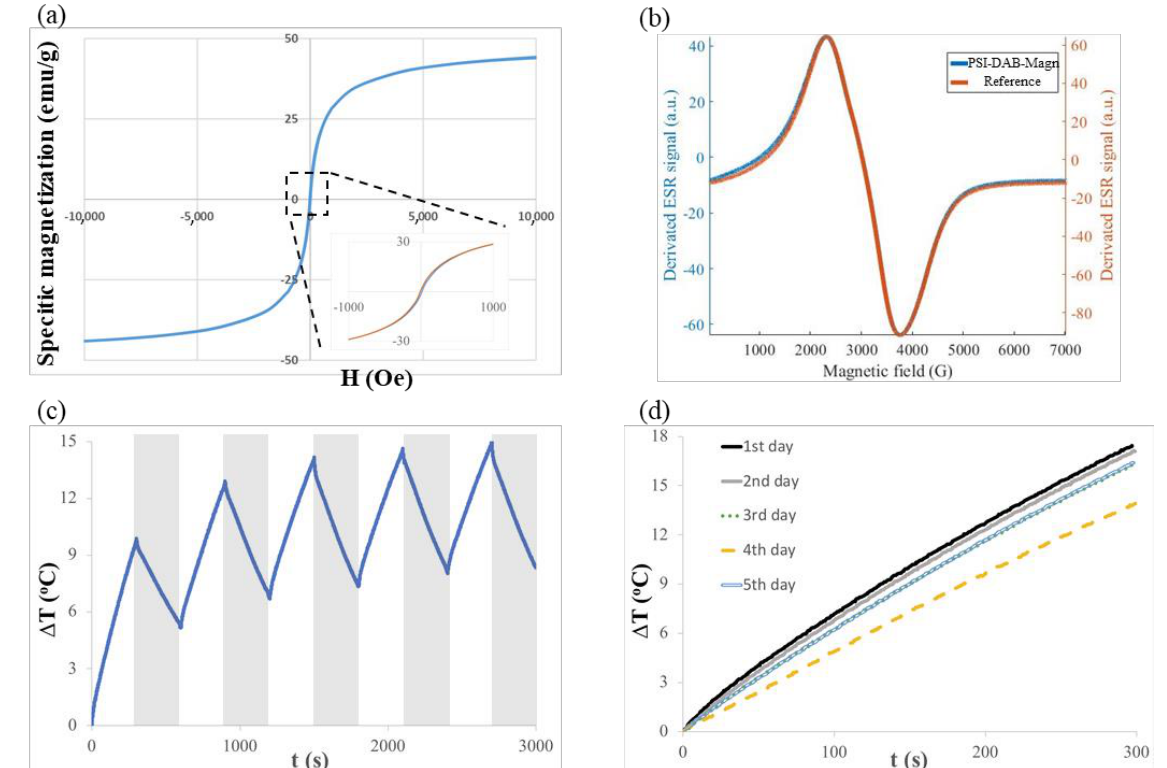
Figure 2. ( a ) A room temperature superconducting quantum interference device (SQUID) study of the crosslinked iron oxide-loaded fibrous sample with a zoom (area with dashed line) showing the absence of any hysteretic behaviour or coercivity. ( b ) Match of the electron spin resonance (ESR) signal of iron oxide with that of the reference signal. ( c ) The change in temperature of the sample during five 5 min heating – 5 min cooling hyperthermic measurement cycles. ( d ) The change in the temperature of the sample during the 5-day repeated hyperthermic measurement.